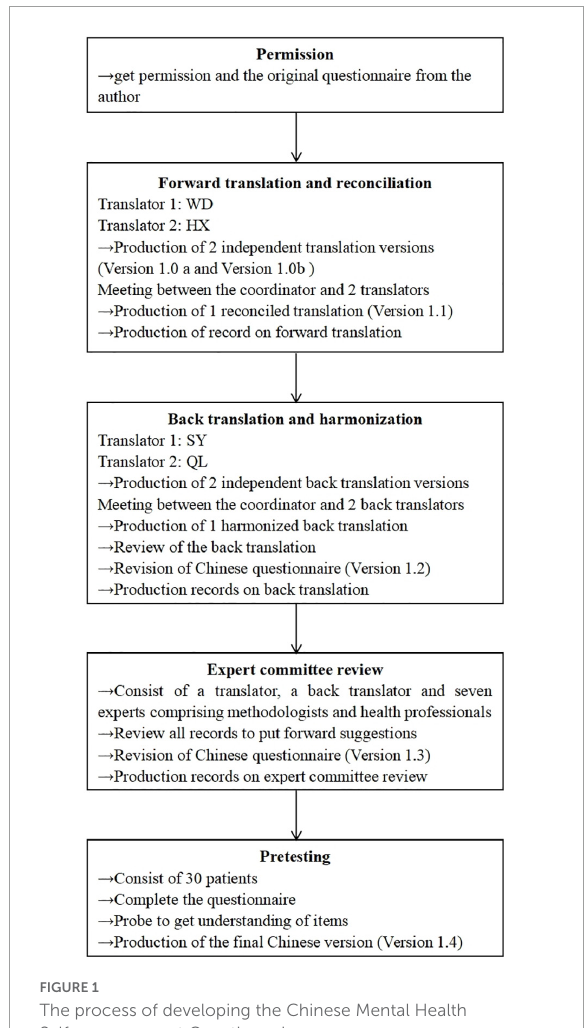
FIGURE1 The process of developing the Chinese Mental Health Self-management